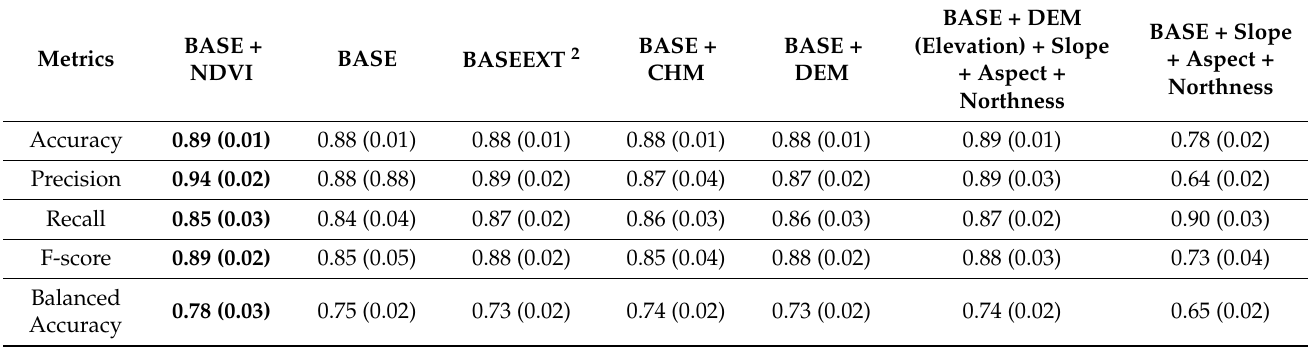
Table A2. Performance metrics in Gunnison River Basin, CO, USA 1